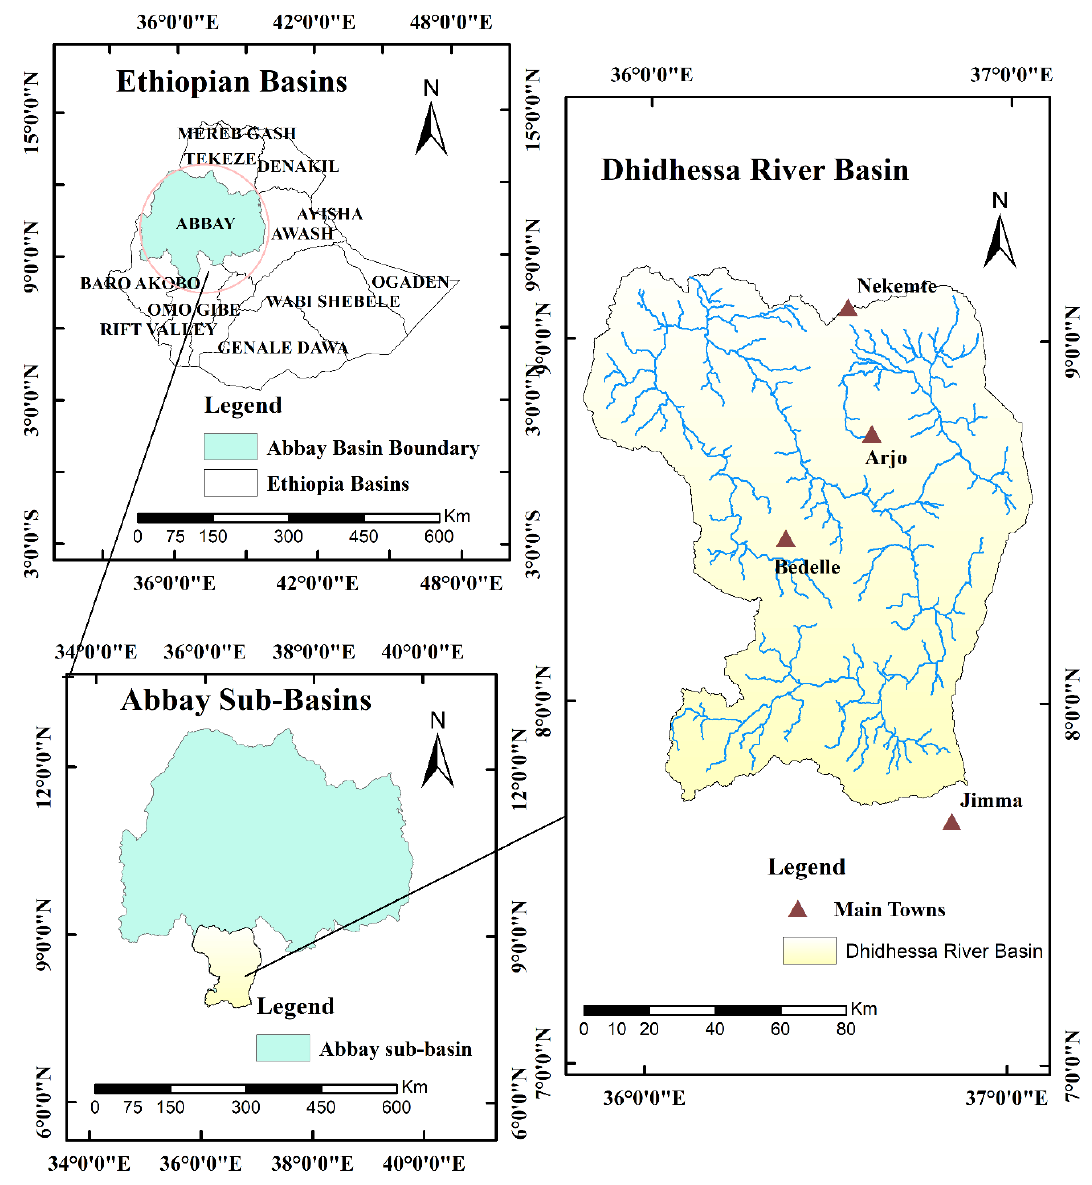
Figure 1. Dhidhessa sub-basin map study site, Abbay Basin,